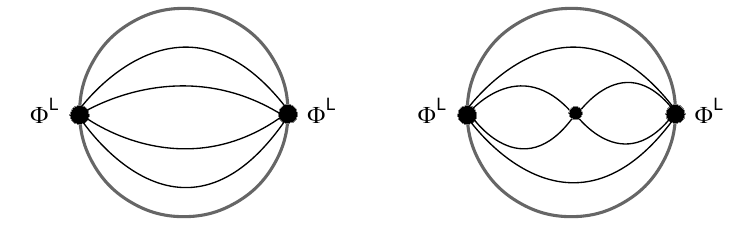
Figure 5 . Topology of Witten diagrams contributing to the 2-point function of (cid:8) L (in the pic- ture the case L = 4 is shown). The diagrams on the left, corresponding to generalized free-(cid:12)eld contractions, also receive a subleading correction where a y -propagator is one-loop